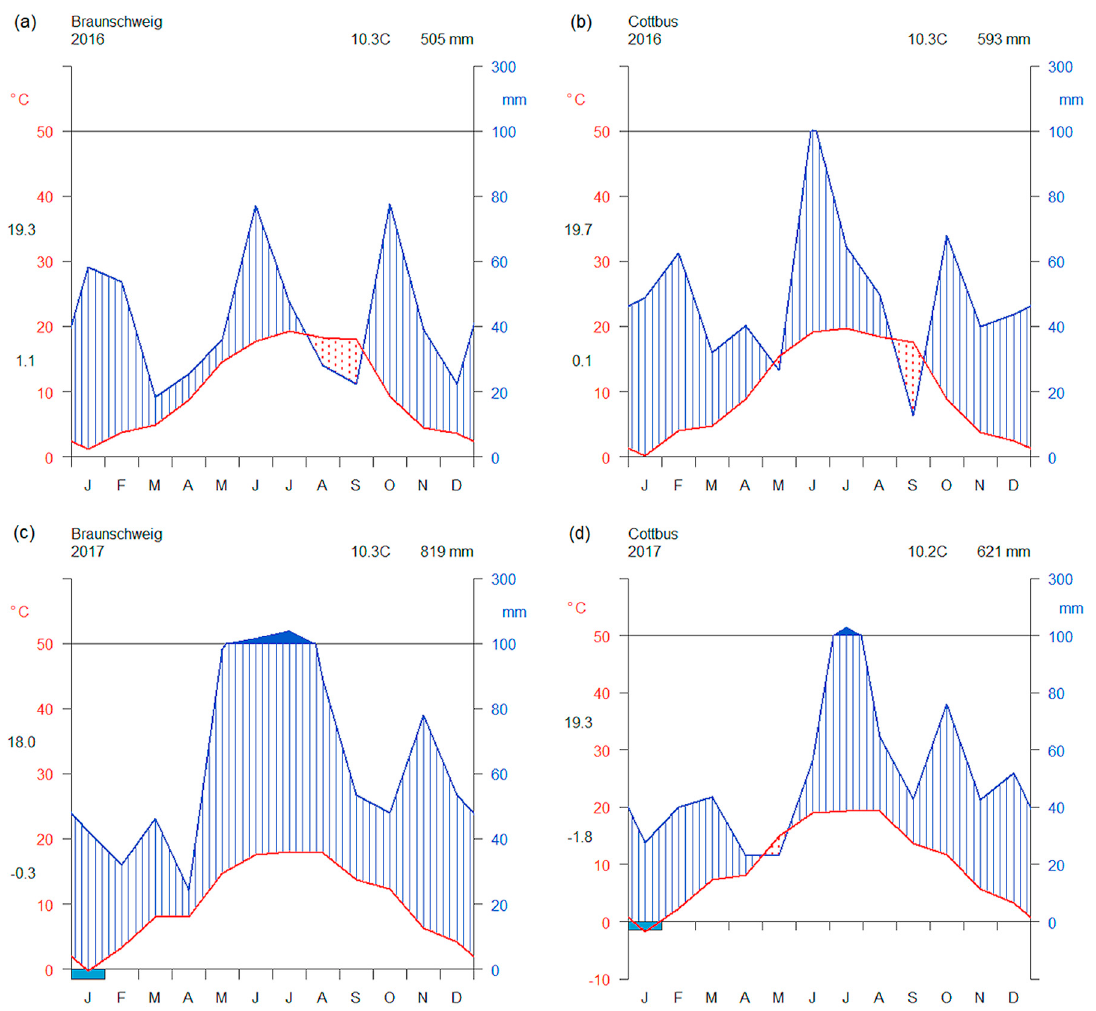
Figure A1. Walter-Lieth climate diagrams for the weather stations at Braunschweig (Wendhausen; a, c) and Cottbus (Neu Sacro; b, d). Monthly values from 2016 ( a, b ) and 2017 ( c, d ) were used to represent the mean air temperature (red) and average precipitation sum (blue). If the average monthly precipitation sum lies under the mean monthly air temperature, the period is considered arid (filled in dotted red vertical lines), otherwise it is considered wet (filled in blue lines). Minimum and maximum annual temperatures are located on the far-left side and annual mean temperatures are located atop, together with the annual precipitation sum. Frost months (when the absolute monthly temperature minimums are equal or lower than 0 °C) are shown in solid blue boxes along the x-axis.